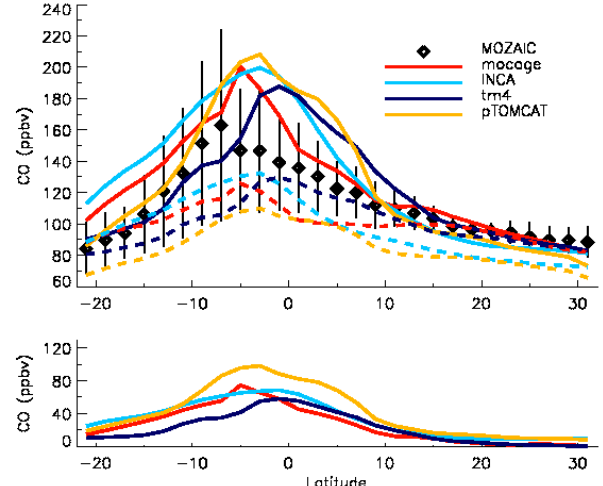
Fig. 4. August 2006 CO UT African transects. Upper panel: (di- amonds) MOZAIC observations with error bars representing the variability (red) MOCAGE (light blue) INCA (dark blue) TM4 and (orange) p-TOMCAT (solid lines) L3JRCv2 inventory (dashed lines) GFEDv2 inventory. Lower panel: differences between simu- lations with the L3JRCv2 and the GFEDv2